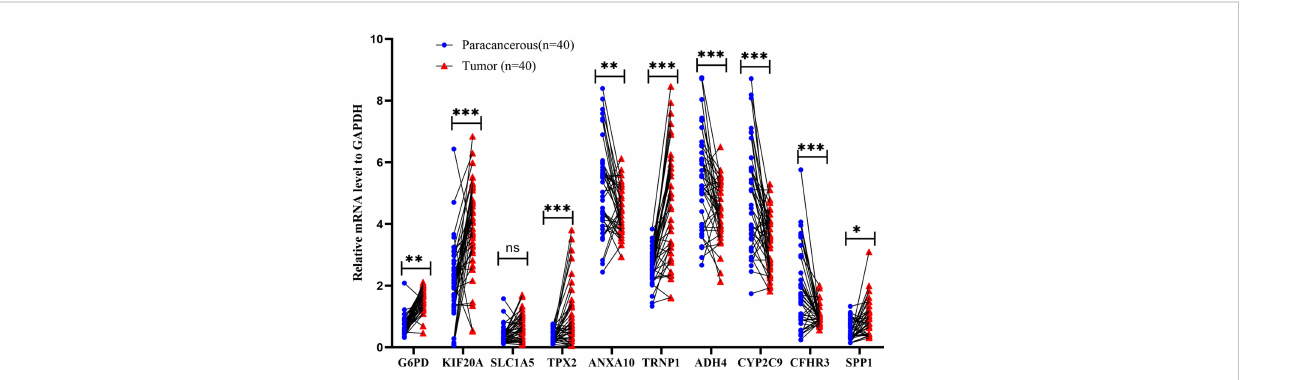
FIGURE 14 Validation of mRNA expression by real-time PCR. mRNA expression of ten genes related to mitophagy in 40 HCC tissues and paracancerous tissues; ns: not statistically signi fi cant, **: p<0.01, ***: